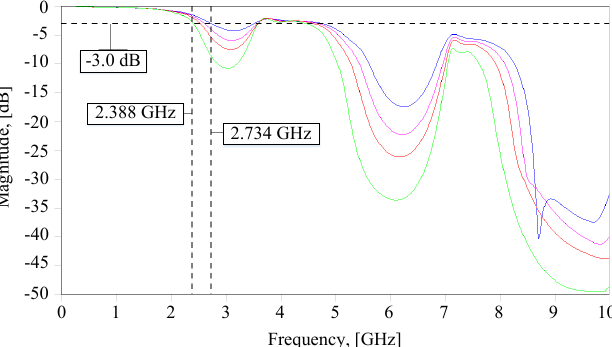
Fig. 4. Magnitude frequency response of the meander line, when a = 0.2 mm (blue); a = 0.4 mm (pink); a = 0.6 mm (red); a = 1 mm (green); Z 0 = 50 Ω